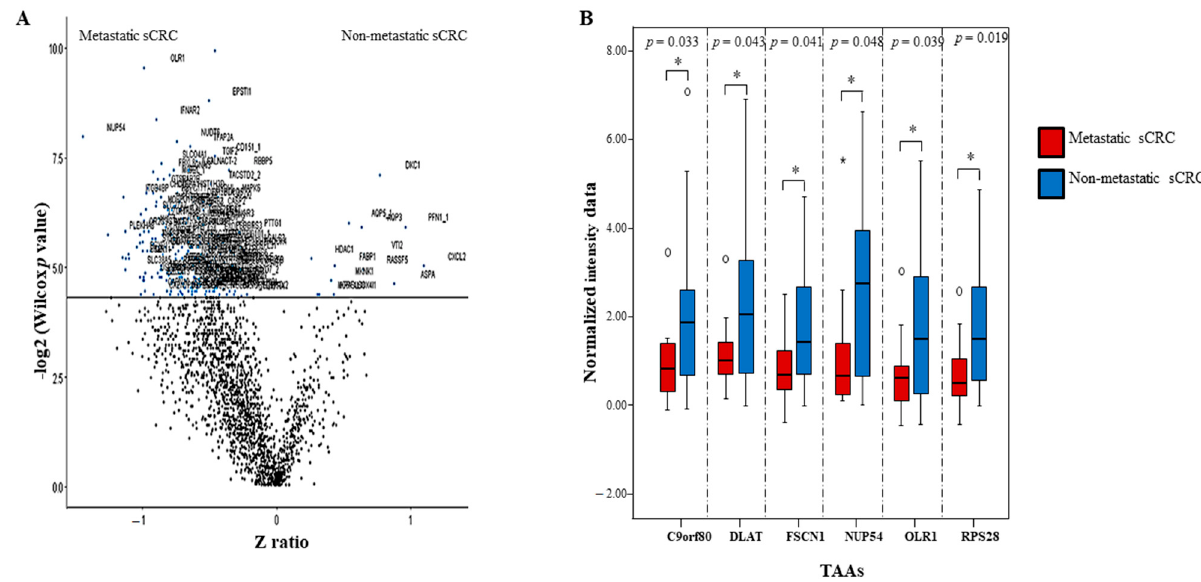
Figure 5. Identification differential aAbs profile between metastatic vs. non-metastatic sCRC. ( A ) Shows volcano plot of all TAAs presented ( n = 141) in the sCRC analyzed samples. ( B ) Represents normalized intensity data of aAbs against TAAs with statistical significance ( p < 0.05) from metastatic sCRC ( n = 12) and no-metastatic sCRC patients ( n = 38). Notched-boxes extend from the 25th to 75th percentile values; the lines in the middle and vertical lines correspond to median values and the 10th and 90th percentiles, respectively. Outlier cases, identified as cases between 1.5–3 and/or > 3 times the interquartile range, are represented by circles and stars, respectively.